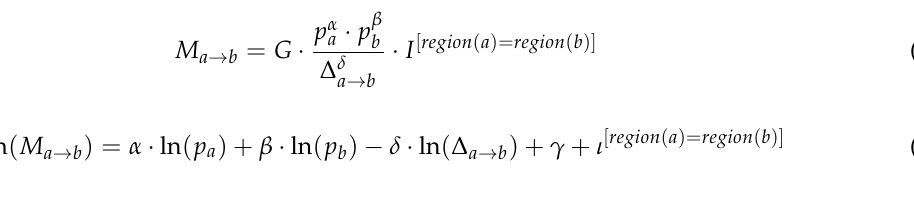
Table 2. Different parameters used in the extended gravity